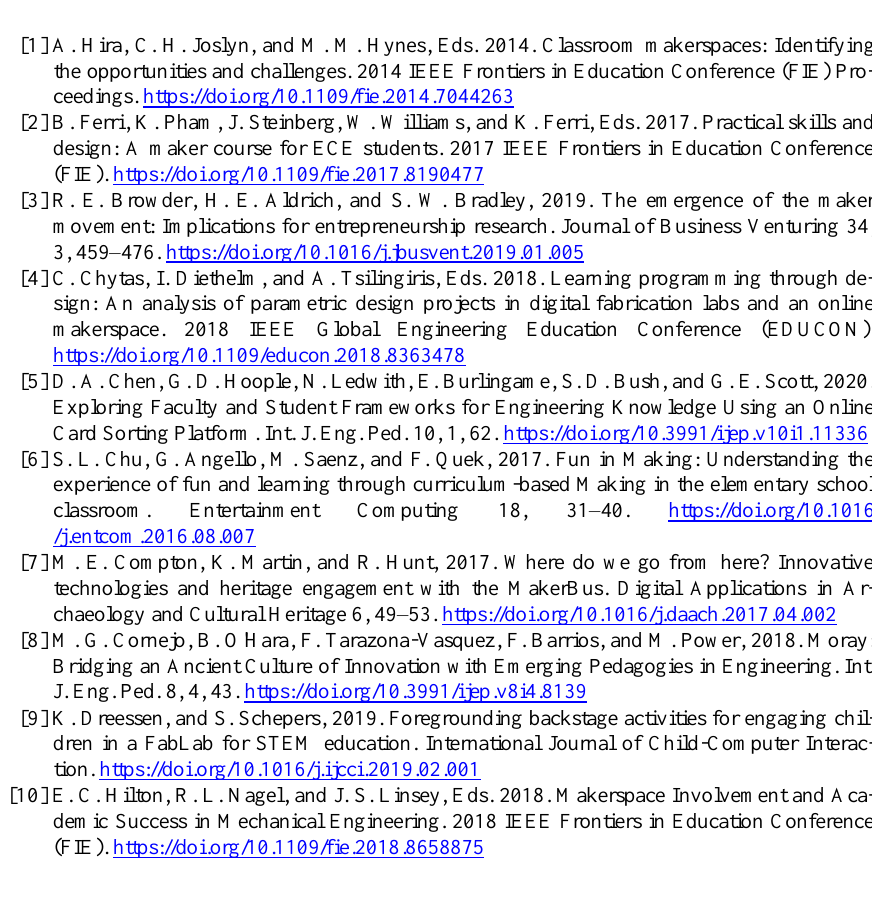
Table 1). Four main categories were identified: External makerspaces, school mak- erspaces, open makerspaces located in schools, and temporary (Pop-up) makerspaces. According to the research questions the taxonomy examines infrastructure, financial structure, and organizational structure of makerspaces in and used by schools featur- ing location, responsibility, funding, instructors, users, time restrictions, and activi- ties. This research also shows the diversity of making in schools and its interdiscipli- narity. The openness of a makerspace seems to be an important factor for informal knowledge transfer and potential (business) partnerships enriching the school envi- ronment. To operate a makerspace in school as a “Social enterprise” [24] is identified to be preferable (as discussed in 3.3 The development trajectory of a school mak- erspace). Therefore, especially the category of open makerspaces located in schools seems in need of further